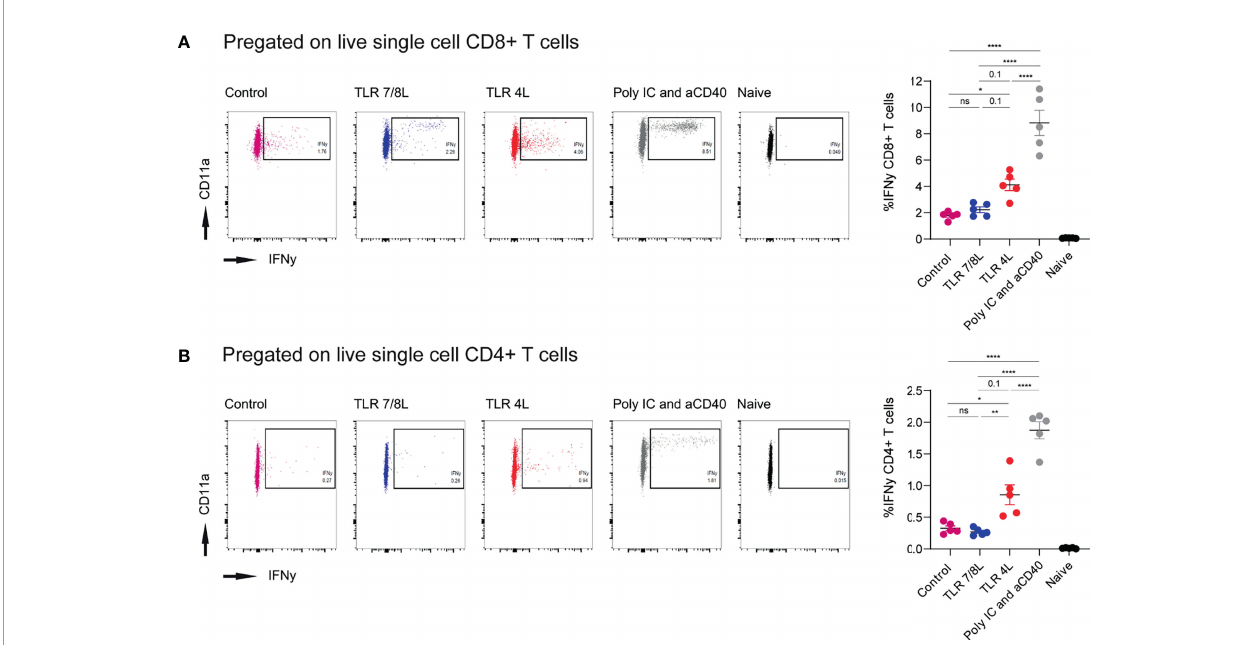
FIGURE 4 | Immunization with antigen-containing GM3 liposomes and TLR4L-containing GM3 liposomes elicits more robust antigen-speci fi c immune responses than antigen-containing GM3 liposomes and TLR7/8L-containing GM3 liposomes. (A, B) Mice were i.v. immunized with antigen-containing GM3 liposomes (22.5 nmol phospholipid) that were supplemented with control GM3 liposomes (no TLR ligand), TLR7/8L-containing GM3 liposomes, TLR4L-containing GM3 liposomes (200 nmol phospholipid), or soluble poly IC and aCD40 antibody as positive control. After 7 days, spleens were collected and a single cell suspension was used for peptide restimulation for 5 or 25 hours for CD8 + and CD4 + T cells, respectively. Indicated are the representative dot plots of IFN g production after peptide restimulation and the average percentage ± SEM of IFN g -producing CD8 + and CD4 + T cells [ (A, B) , respectively] ( n = 3-5). **p < 0.01 and ****p < 0.0001. *p < 0.05, ns, not signi fi